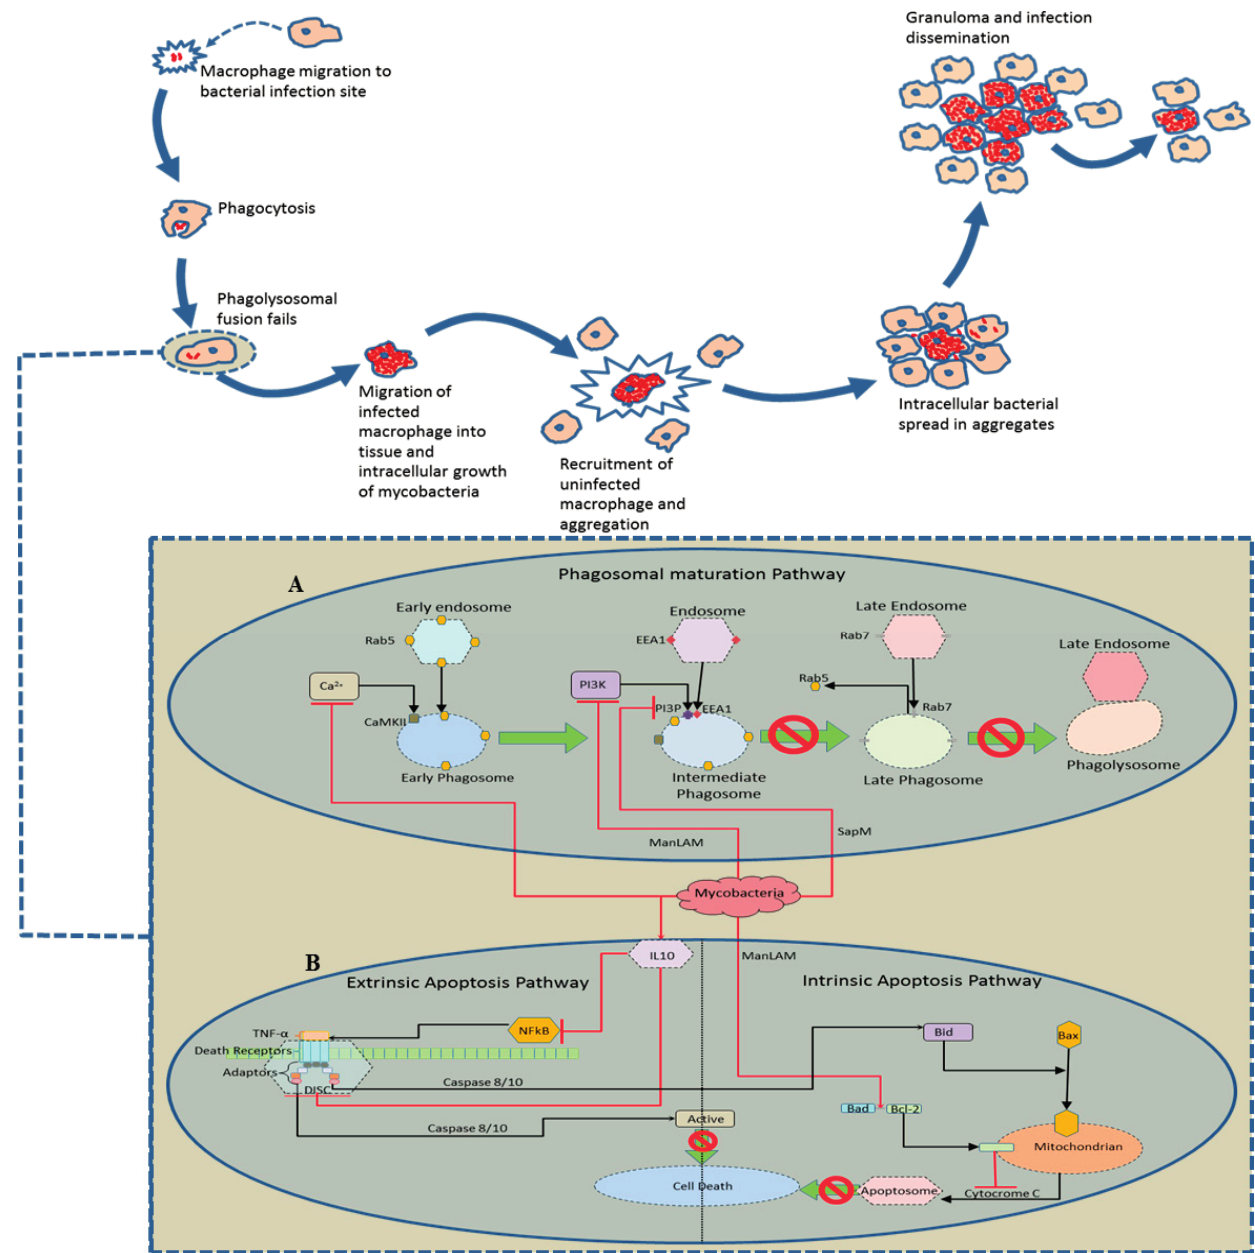
Figure 1. Infection at cell dynamic level and interaction between macrophage and bacteria at the intercellular, intracellular, and molecular level (partially adapted from [23]). ( A ) is a graphical representation of the molecular interactions in the phagosome maturation pathway and ( B ) is a graphical representation of the apoptosis